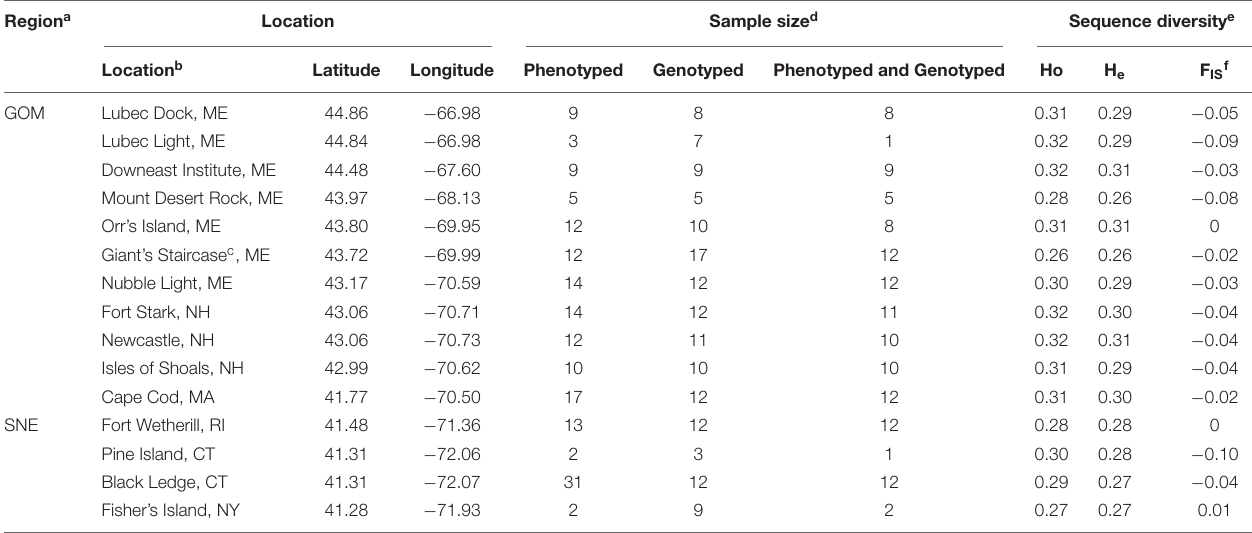
TABLE 1 | Location, sample size, and sequence diversity for sampling